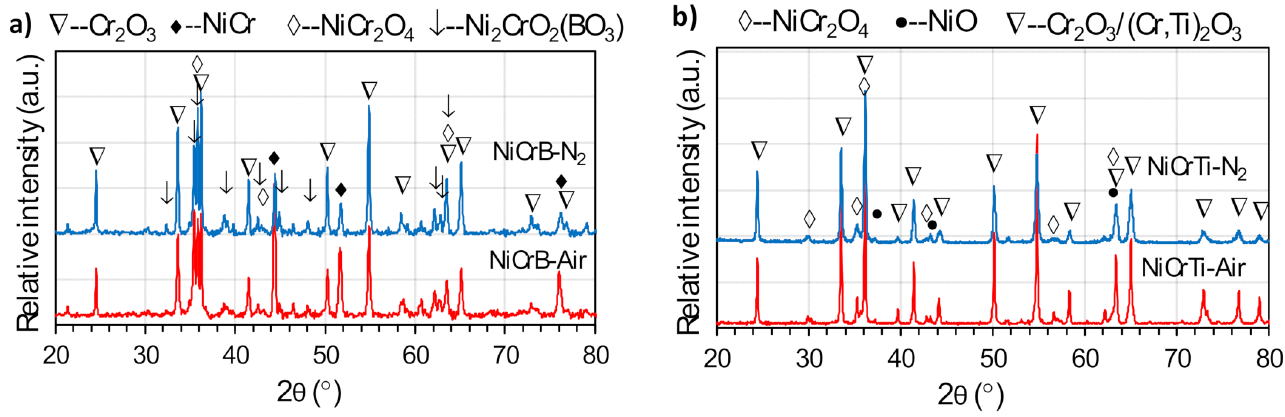
Figure 5. XRD patterns of ( a ) NiCrB and ( b ) NiCrTi coatings with air-atomization and nitrogen- atomization after the hot corrosion